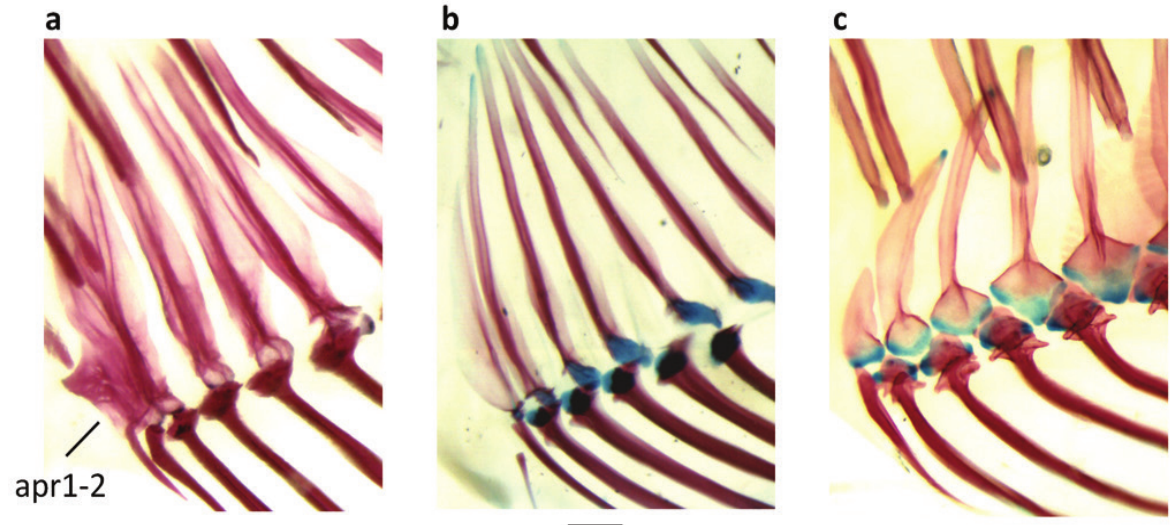
Fig. 5. Anterior section of anal fin of a. Papiliolebias bitteri , b. Pterolebias longipinnis , c. Ophthalmolebias constanciae ; apr1-2 = proximal radials fused. Scale bar = 1